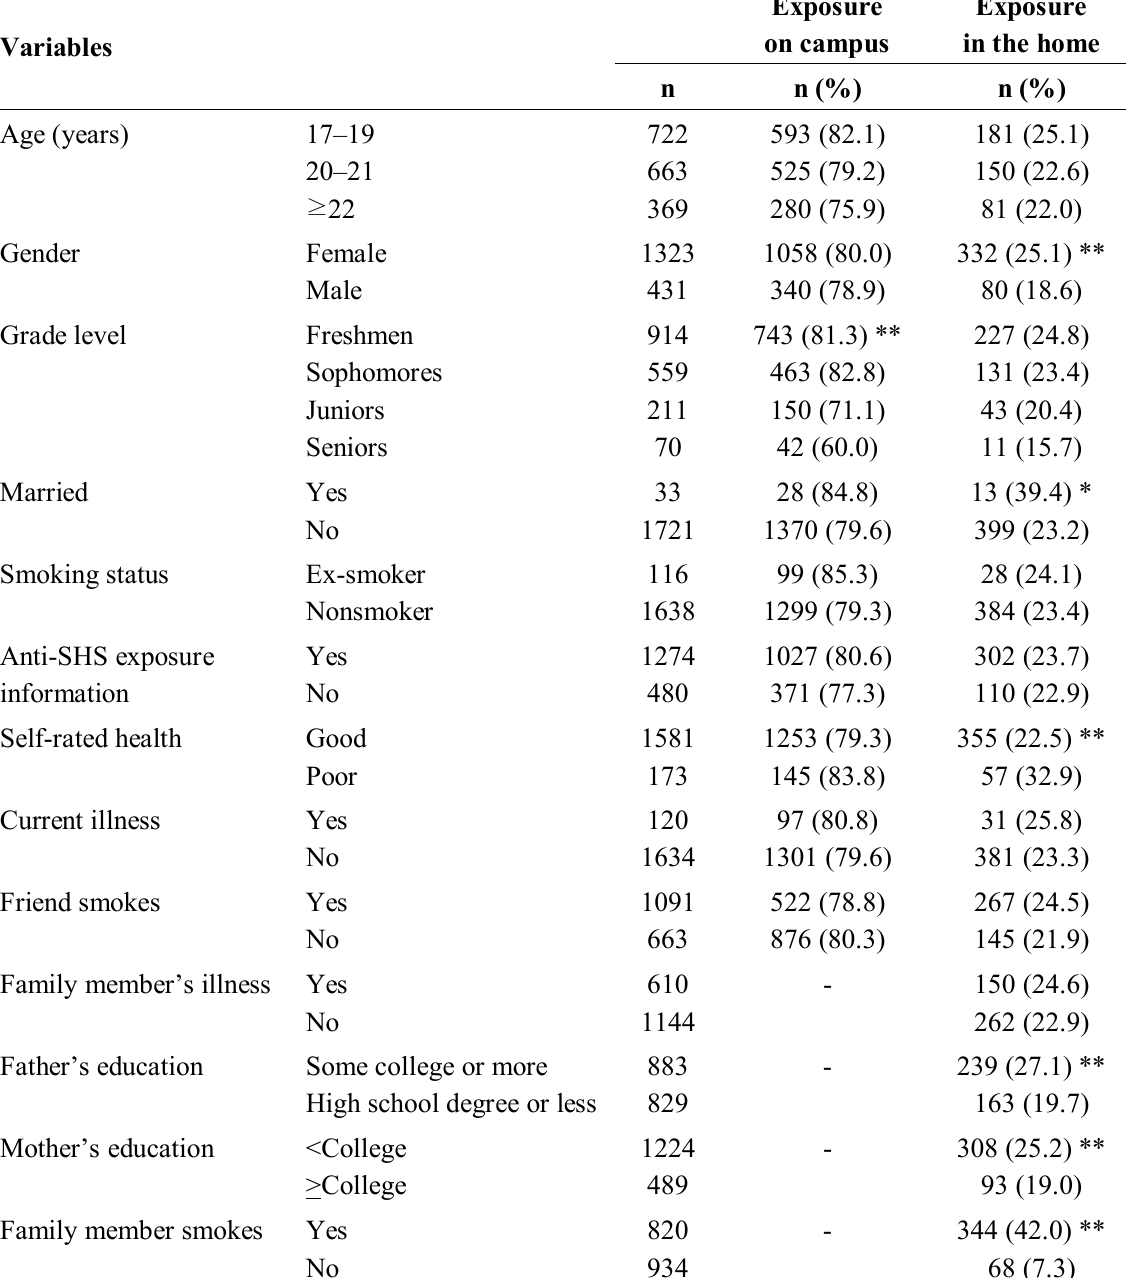
Table 3. Secondhand smoke exposure by location (N =